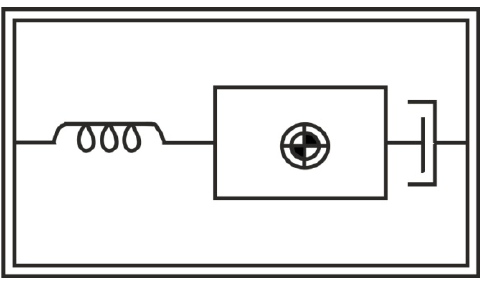
Figure 4. Basic spring-mass system accelerometer